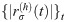
Randomizations revealed that interactions between Moran effects were important for long-timescale PCI synchrony.Mean squared model synchrony {|rσ(h)(t)|}t (Methods) at long timescales for our best long-timescale model (cyan line), compared to {|rσ(h)(t)|}t using synchrony-preserving surrogates (black line) and asynchronous surrogates (magenta line) of C. finmarchicus data. The best model had predictors growing season temperature and C. finmarchicus abundance, and synchrony-preserving surrogates randomized away interactions between these climatic and top-down Moran effects while retaining the effects themselves. Black and magenta lines show average results across 1000 surrogates. C. fin. = C. finmarchicus; unsync. refers to surrogates of the C. finmarchicus data for which synchrony, as well as relationships with temperature data, has been randomized away.